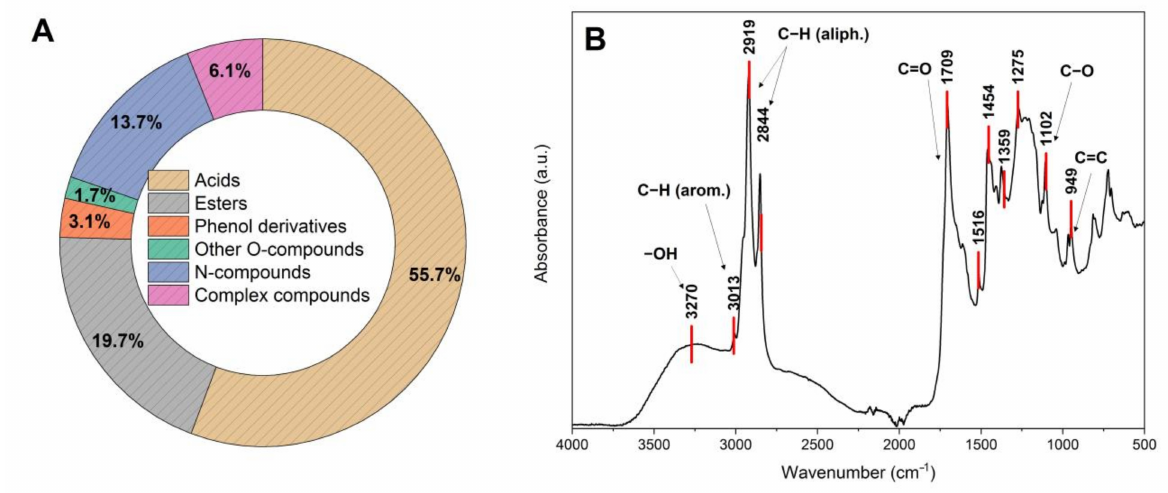
Figure 3. Composition of the resultant HTL biocrude from blackcurrant pomace based on ( A ) GC-MS analysis, ( B ) ATR-FTIR